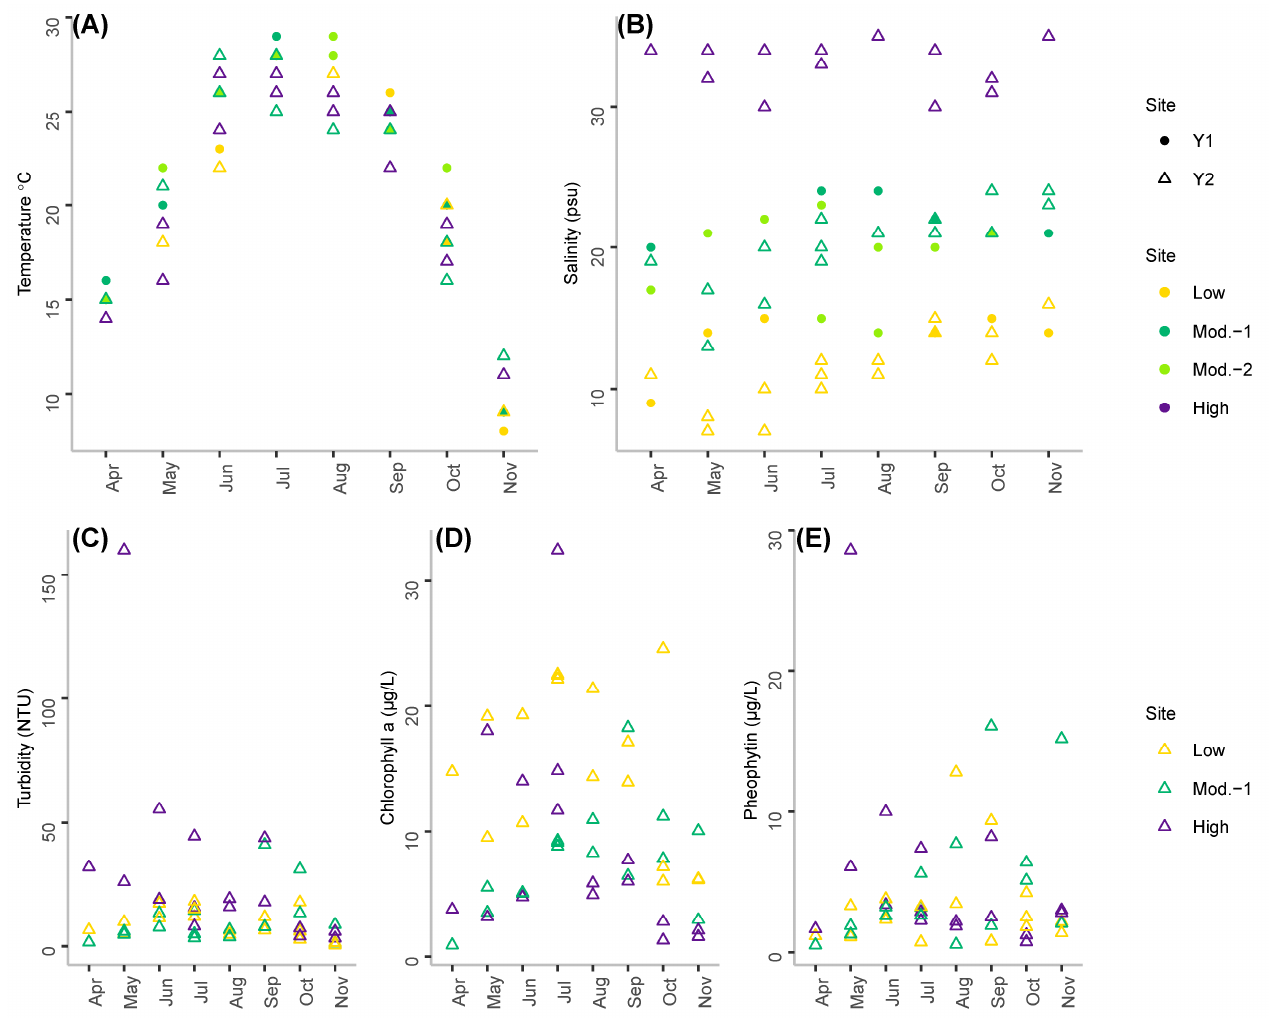
Figure 2. Environmental parameters measured during the study. ( A ) water temperature and ( B ) salinity measured at each site during both studied years. ( C ) turbidity, ( D ) chlorophyll a and ( E ) pheophytin measured in Year 2 of the study.